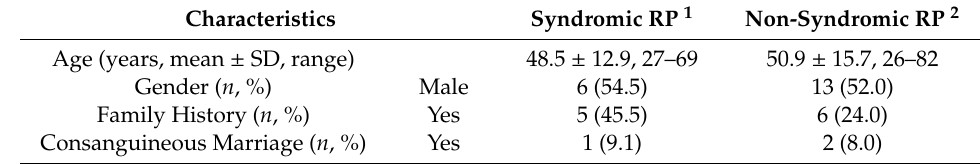
Table 2. Characteristics of syndromic and non-syndromic RP